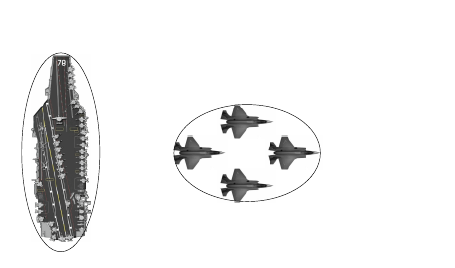
Figure 1. Description by ellipses of the target’s physical extension. A large ship ( left ) and an aircraft formation ( right